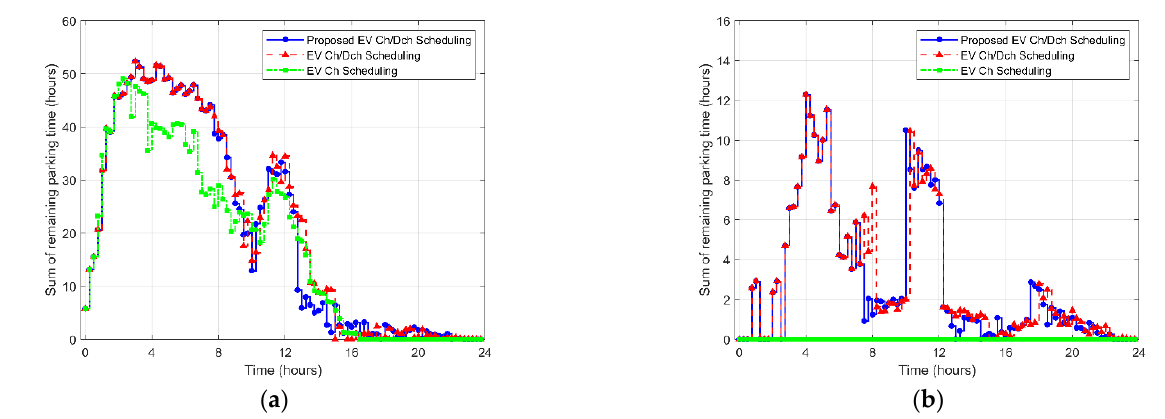
Figure 13. ( a ) The sum of remaining parking time of EVs to be charged; ( b ) The sum of remaining parking time of EVs to be discharged.